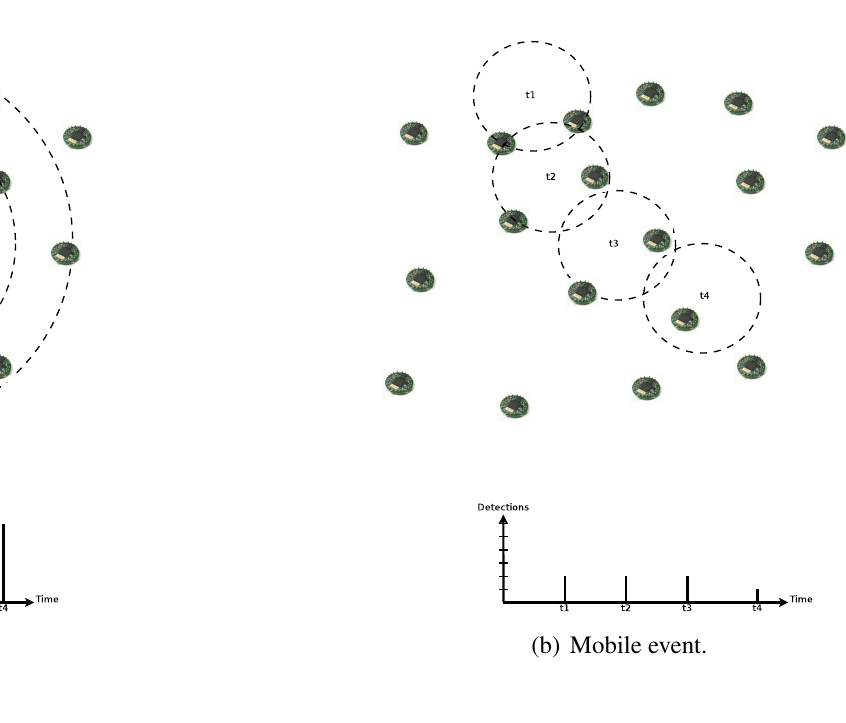
Figure 5. Examples of event occurrences and